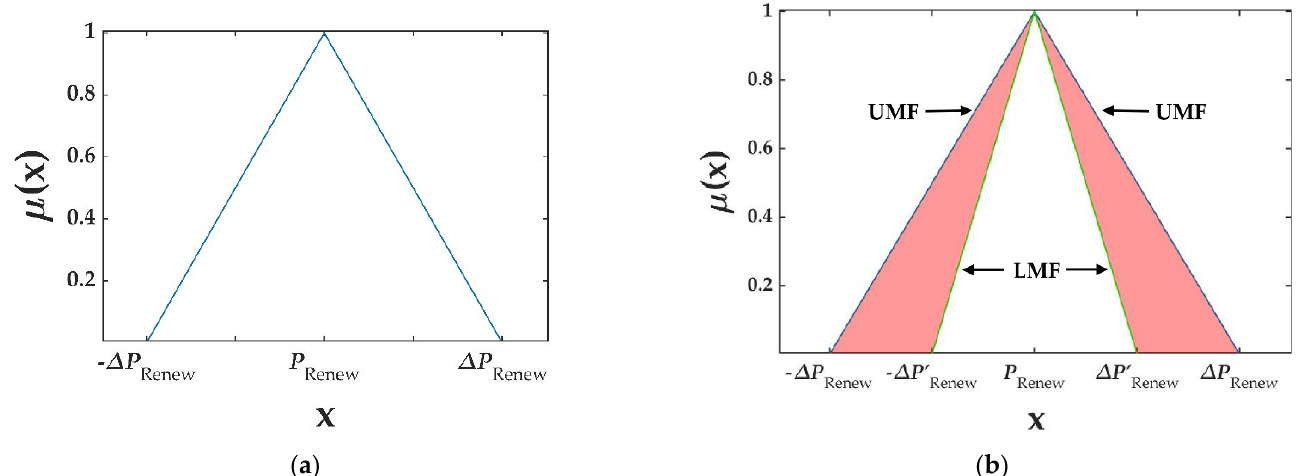
Figure 1. Fuzzy membership function. ( a ) Type − I membership function. ( b ) Type-II membership function.